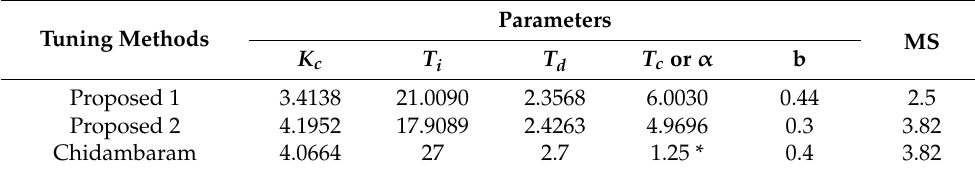
Table 7. Parameter tuning for process 𝑃 3 .